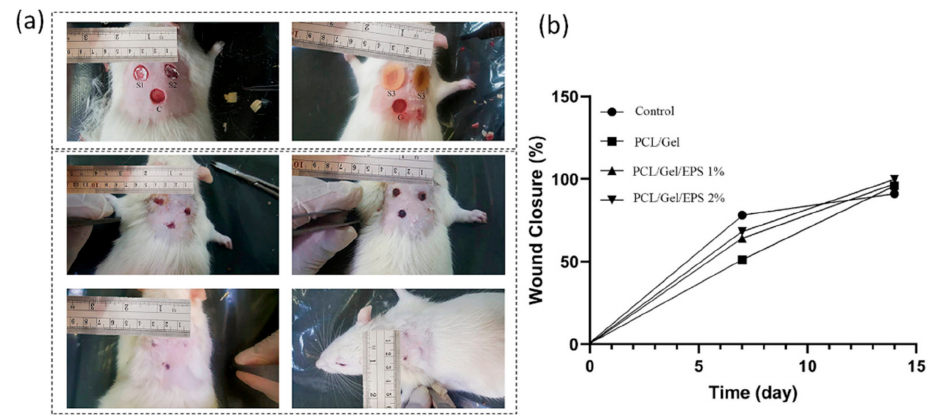
Figure 6. ( a ) Macroscopic images of wound area and closure rate (from 0 to 14 days) for the control and treated groups with PCL/Gel, PCL/Gel/1% EPS, and PCL/Gel/2% EPS nanofiber samples. ( b ) wound closure rate was measured 15 days post-surgery.